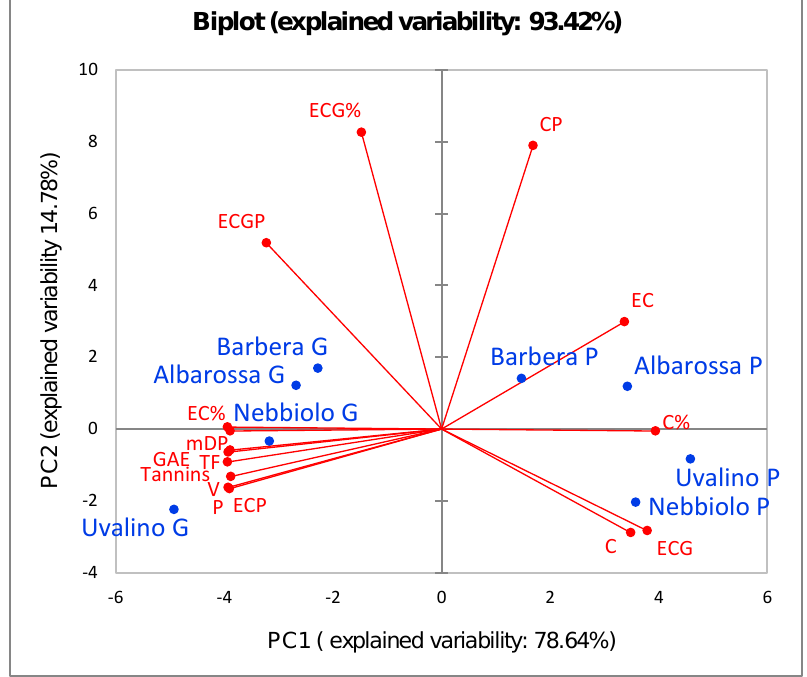
Figure 3. Representation of the loadings (variables) and the scores (seed extracts) in the plane defined by the 1st and 2nd Principal Components (PCA). For each cultivar (blue), the suffix G represents grape extracts, P represents pomace extracts. In red are reported the chemical variables that describe the polyphenolic profile of the extracts: GAE = total polyphenols; TF = total flavonoids; TA = total anthocyanins; MA = monomer anthocyanins; V = flavans reactive with vanillin; P = proanthocyanidins; Tannins = condensed tannins (phloroglucinolysis); mDP = mean degree of polymerization; C, EC, ECG = (+)-catechin, (−)-epicatechin and (−)-epicatechin-3- O -gallate present as terminal units; CP, ECP, ECGP = (+)-catechin, (−)-epicatechin and (−)-epicatechin-3- O -gallate present as extension units; C%, EC%, ECG% = total percentages of the monomers (terminal + extension).